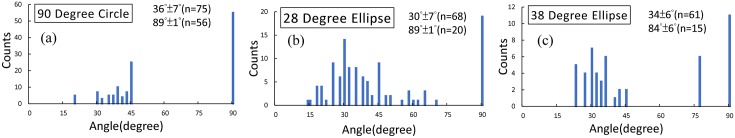
Distribution of branch angles of dendritic architectures with nanopost guided.That is, the angle between the primary-branch and the secondary-branch of the dendritic architecture. Histograms of branch angles on (a) 90°, (b) 28°, and (c) 38° nanopost substrates. The distributions show twin peaks. The first peak is around 90°, and the second peak is 36° ± 7° for 90 degree circle, 30° ± 7° for ellipse28, and 34° ± 6° for ellipse38.